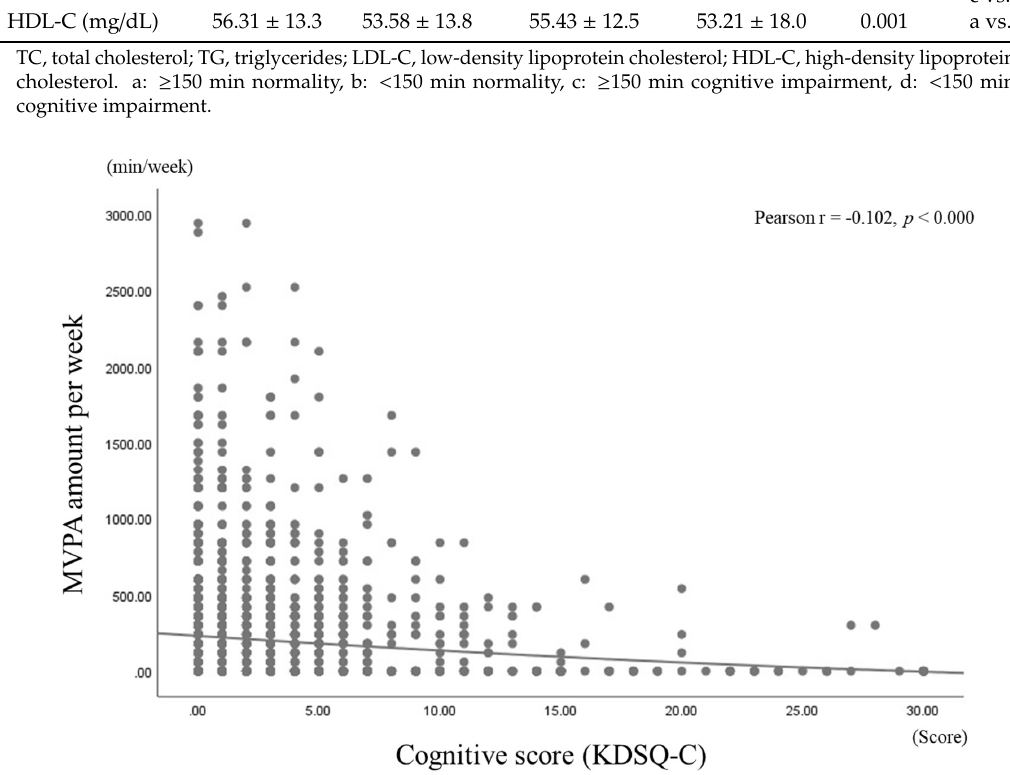
Figure 1. Pearson’s correlation coefficients for cognitive scores and weekly MVPA amounts.